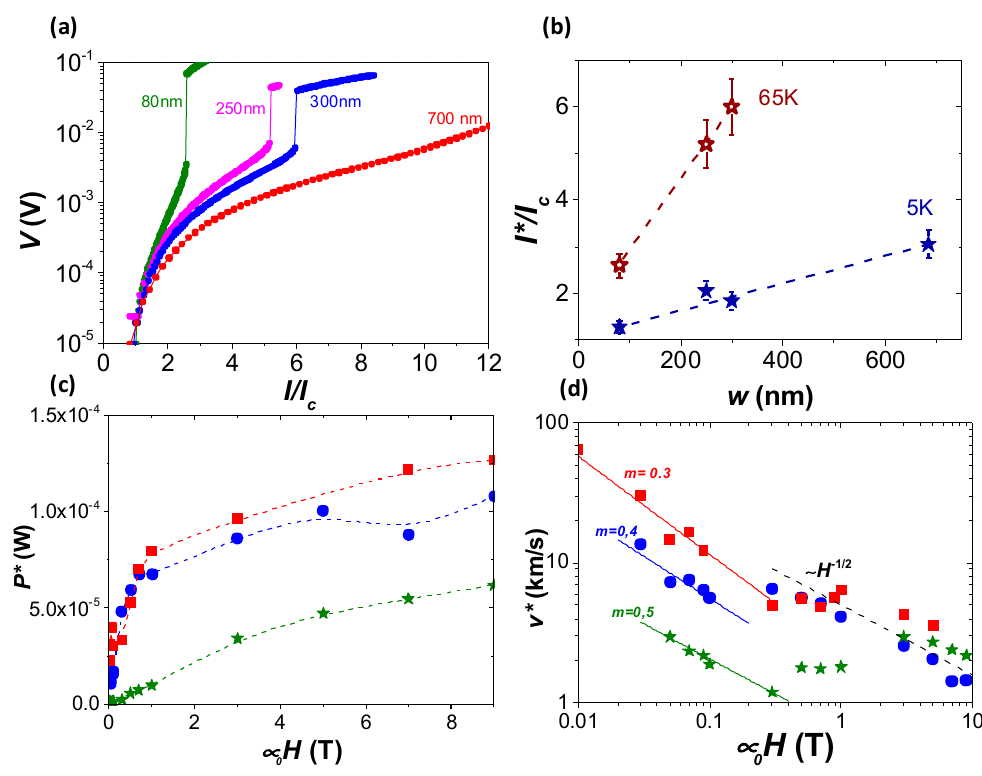
Figure 5. ( a ) I - V characteristics obtained for different nanowires at 65 K and 1 T. ( b ) I*/I c as a function of the width of the nanowire, at 1 T and different temperatures. ( c ) Magnetic field dependence of P* at 5 K, for nanowires with w = 700 nm (squares), 300 nm (circles), and 80 nm (stars). ( d ) Magnetic field dependence of v* at 5 K, for nanowires with w = 700 nm (squares), 300 nm (circles), and 80 nm (stars). Dashed lines indicate a v* ~ H − 1/2 and solid lines v* ~ H − m dependences.